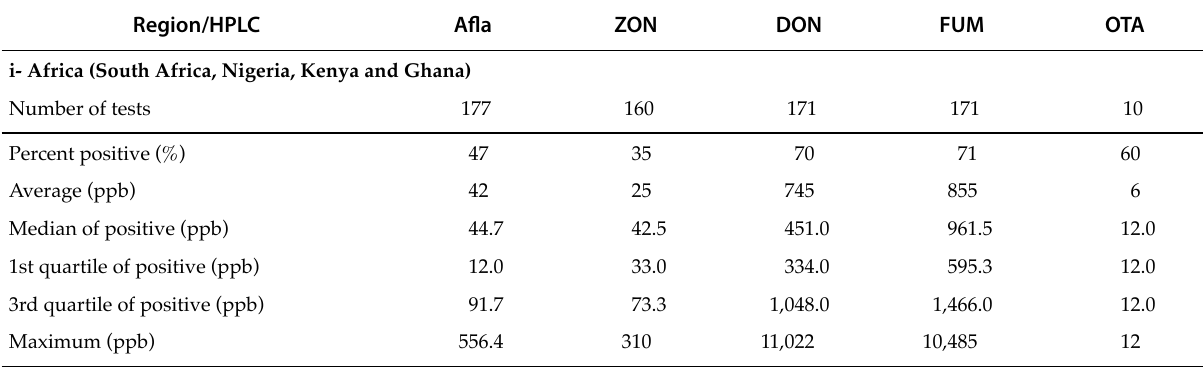
Table 6. Continues .